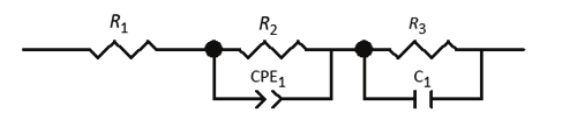
Fig. 3 – Equivalent circuit for steel corrosion in saline solu- tions with addition of 200 µL and 500 µL of